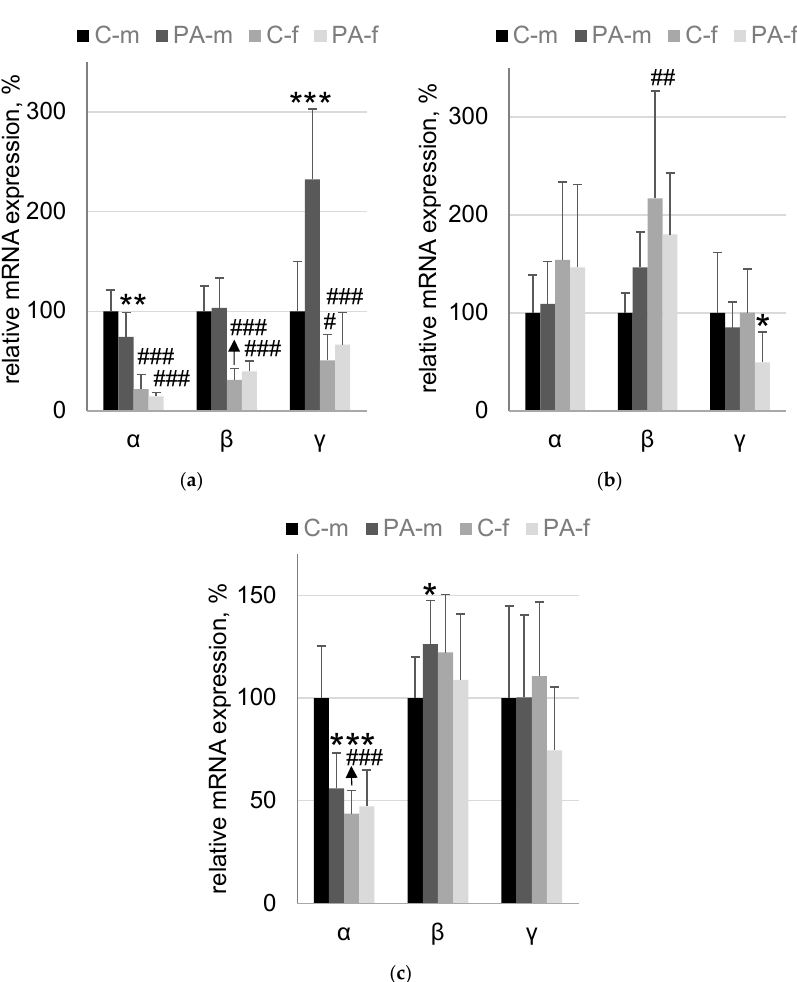
Figure 4. The mRNA expression levels of synucleins. ( a )—the hippocampus; ( b )—the hypothalamus; ( c )—the midbrain. The corresponding members of the synuclein family are indicated by Latin letters: α , β and γ . C-m—male naïve rats, n = 9; PA-m—male PAE rats, n = 9; C-f—female naïve rats, n = 9; PA-f—female PAE rats, n = 9. Asterisk (*) indicates a significant difference between naïve and PAE rats of the same sex: *— p < 0.05; **— p < 0.01; ***— p < 0.001; a post hoc Duncan’s test. Hash